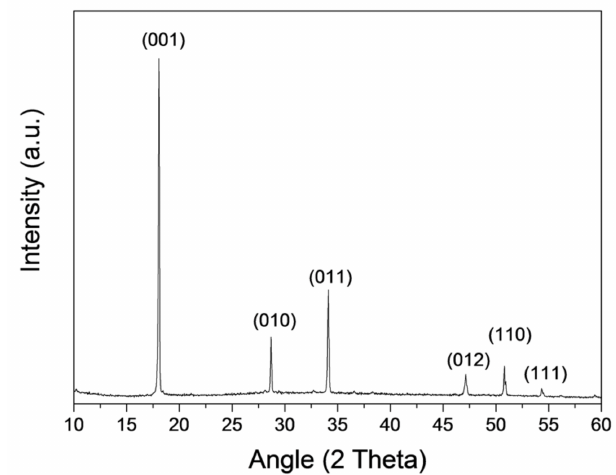
Figure 4. XRD diffraction pattern of the N ANO LAQ suspension sample after drying under nitrogen atmosphere. The Bragg peak is indexed by the Miller index of Portlandite (ICDS